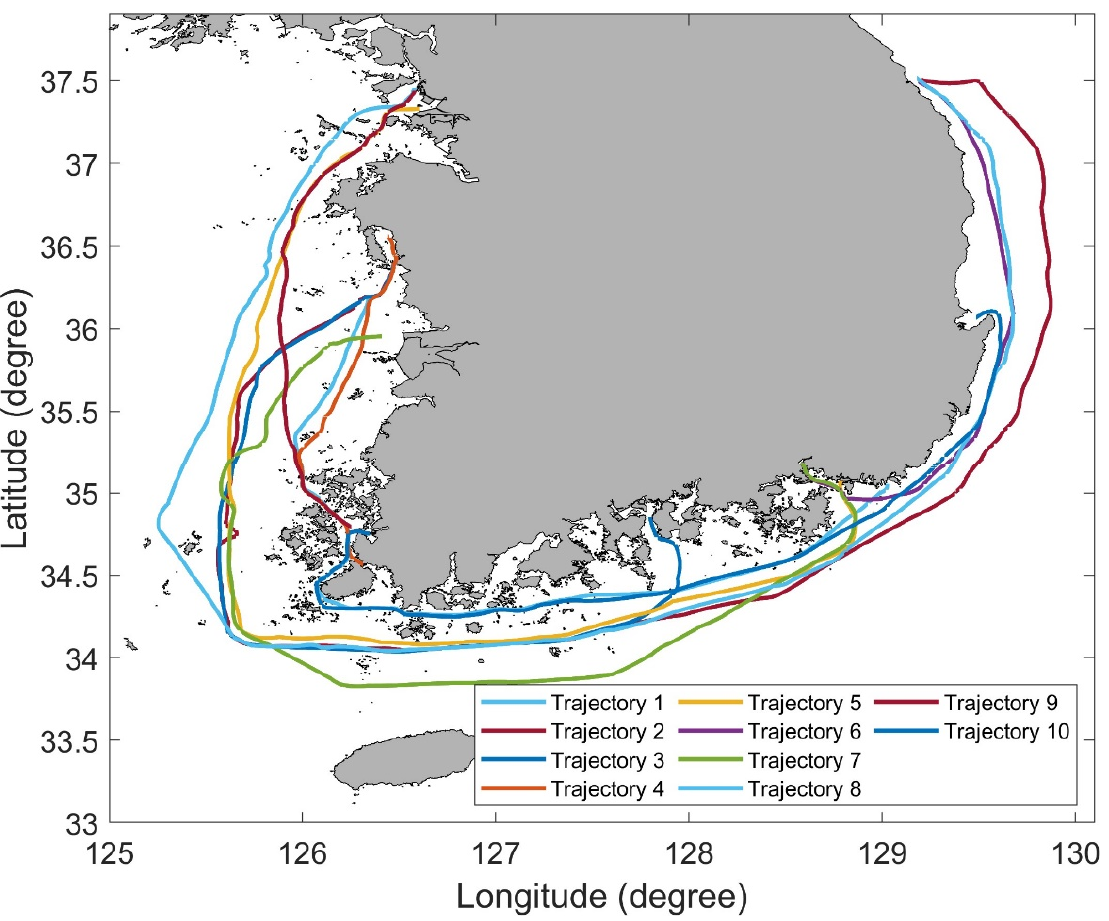
Figure 7. AIS trajectories in Korean sea for verifying the performance of the proposed algorithm.